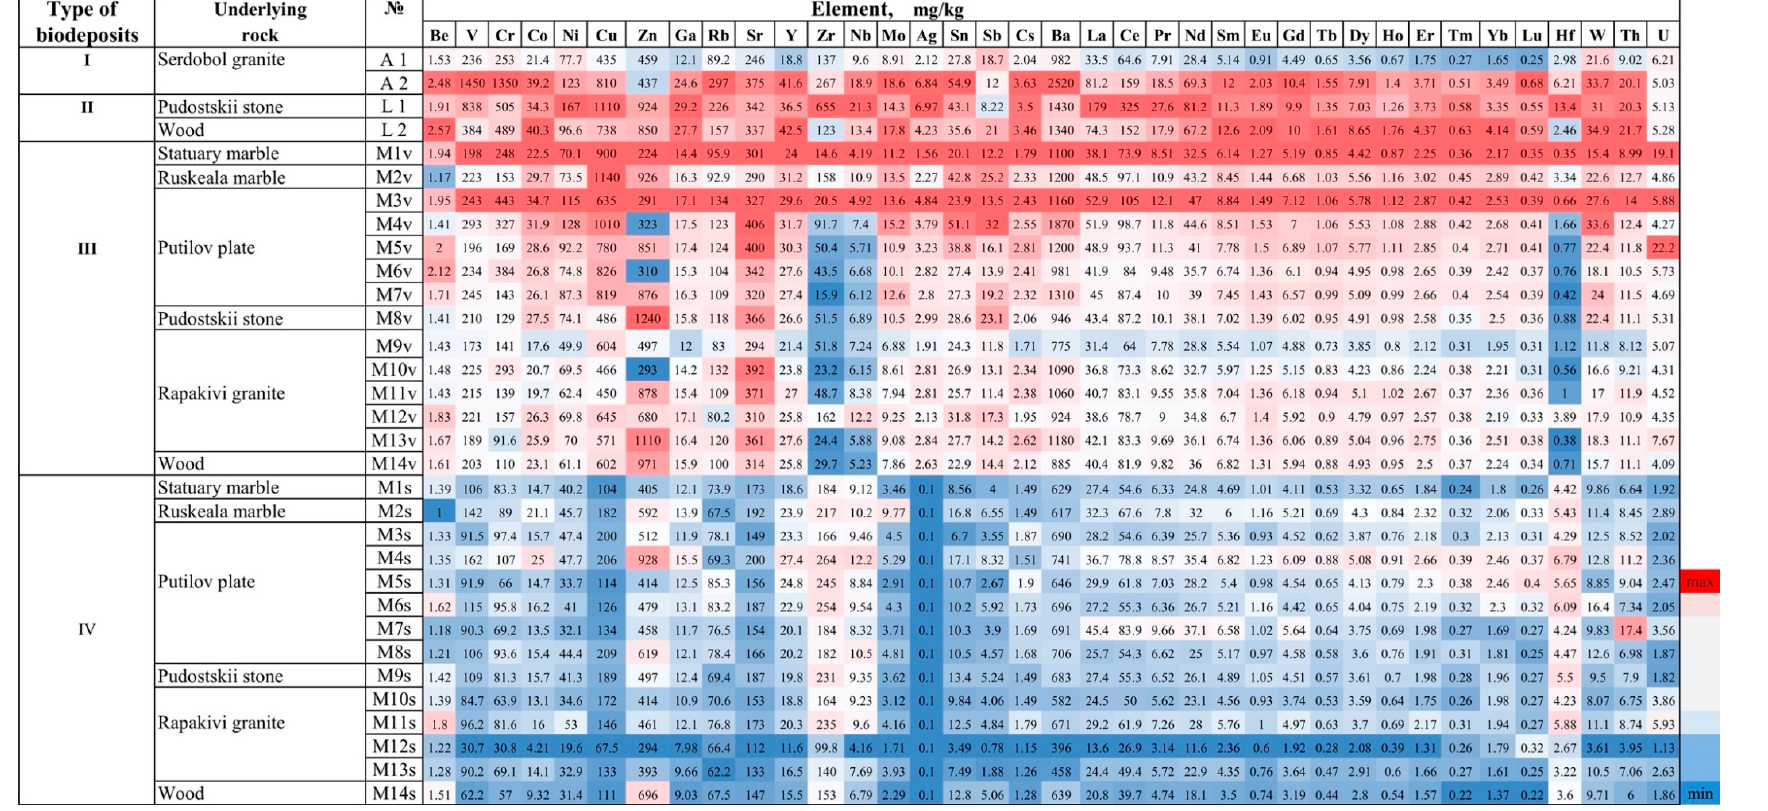
Figure 6. Heat map of trace impurity elements (mg/kg) in the biodeposits on the surface of the different rocks (1 mg/kg = 10 -5 wt%).